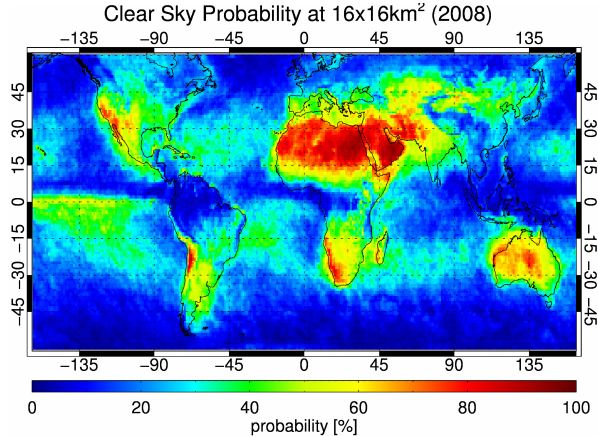
Fig. 5. Clear-sky probability from MODIS calculated at 16 × 16km 2